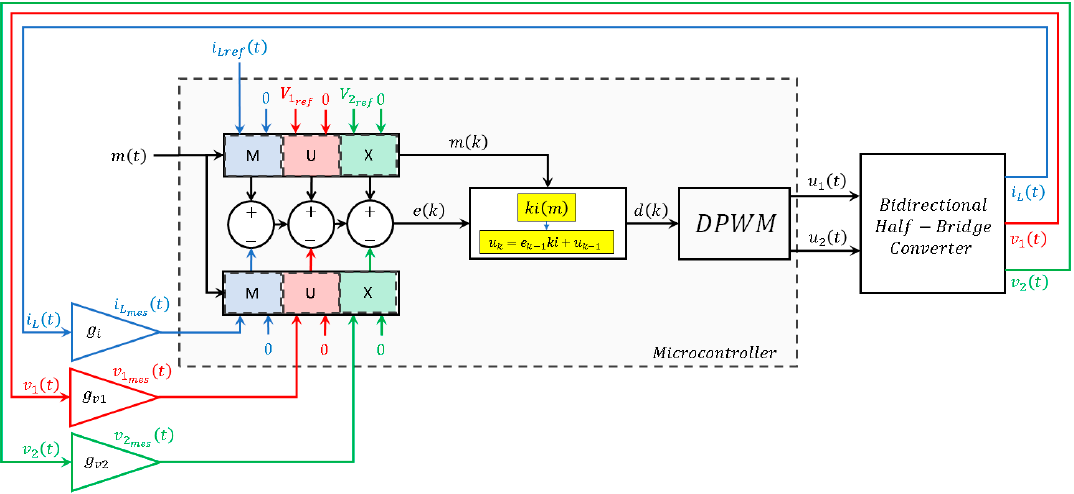
Figure 10. Block diagram of the unified multimode control for the BHCB.